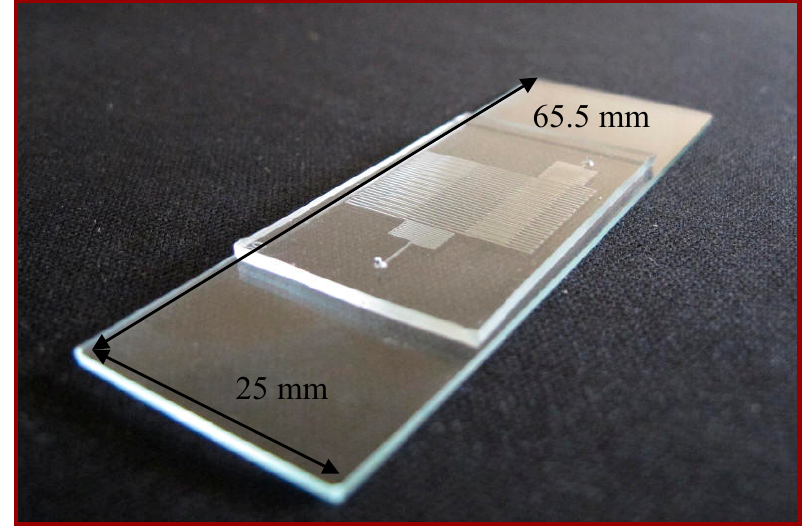
Figure 2. The PCR chip consists of a polydimethylsiloxane (PDMS) and a glass layer. The mixture is injected into the channel through the inlet and is driven by the syringe